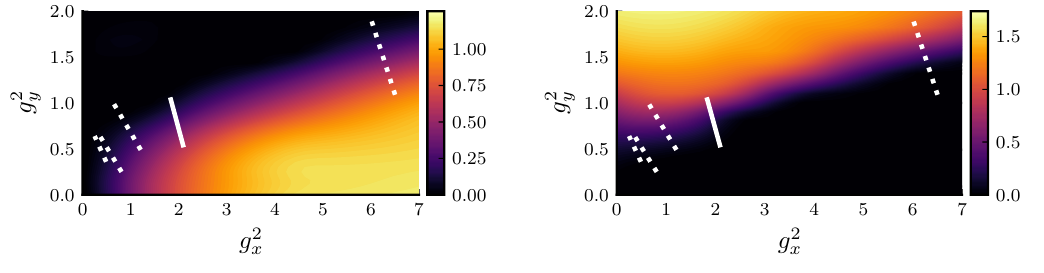
Figure 4 . The phase diagram as computed with infinite MPS with truncation error (cid:15) ≈ 10 − 4 . We show the expectation value of the σ (left) and π (right) order parameters as a function of g 2 The full white line indicates the cut that we will analyse in detail below, the dotted lines depict lines we used to study the scaling of K towards the continuum limit.